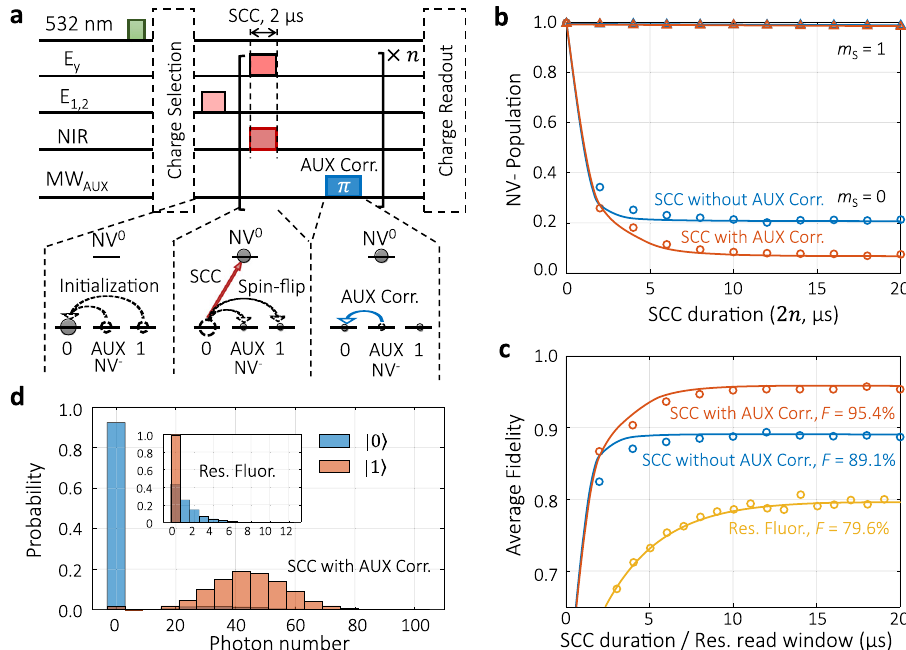
Fig. 3 Single-shot readout of NV electron spin state via SCC. a Pulse sequence and diagram illustrating NV spin and charge dynamics for 0 j i readout fi delity evaluation. As the spin- fl ip process traps some populations in 1 j i and AUX state, an MW π pulse rescues the part in AUX state back to 0 j i so AUX that they can be ionized in the next round. The SCC pulse and AUX correction (AUX Corr.) pulse are repeated for n rounds to get the optimal ionization. The sequence for evaluating 1 j i readout fi delity only differs in the spin initialization part, which is an E y + MW AUX pulse of 200 μ s. b NV − population dependence on SCC duration (2 μ s × n ). The solid lines for 0 j i are simulations. The solid lines for 1 j i are linear fi ts to the data. c Average fi delity dependence on E y illumination time for different readout methods. In SCC methods E y illumination time equals the SCC duration, and in resonance fl uorescence method it equals the read window. Blue and orange solid lines are the average of the corresponding lines in ( b ). The yellow line is an exponential fi t to the results of the resonance fl uorescence (Res. Fluor.) method. d Photon number distribution of the charge readout with the SCC method. This is obtained from 20,000 measurement repetitions with NV spin initially prepared in the 0 j i (blue) and 1 j i (orange). Inset: photon distribution for the resonance fl uorescence method.